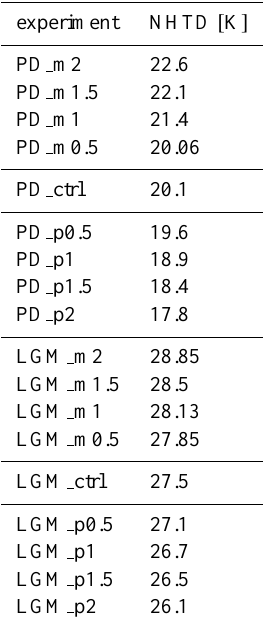
Table 2. Resulting Northern Hemisphere meridional temperature difference (NHTD) from the various